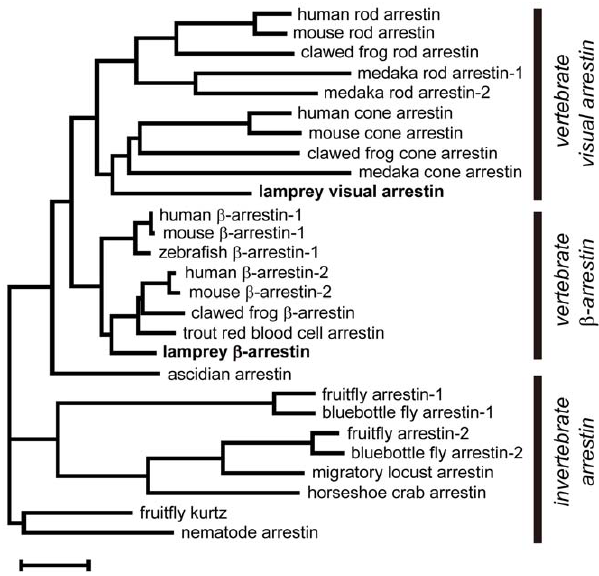
Figure 1. Phylogenetic positions of lamprey arrestins. The two arrestins isolated from the lamprey pineal organ were classified into the vertebrate visual arrestin and the vertebrate b -arrestin groups. Scale bar, 0.1 substitutions per